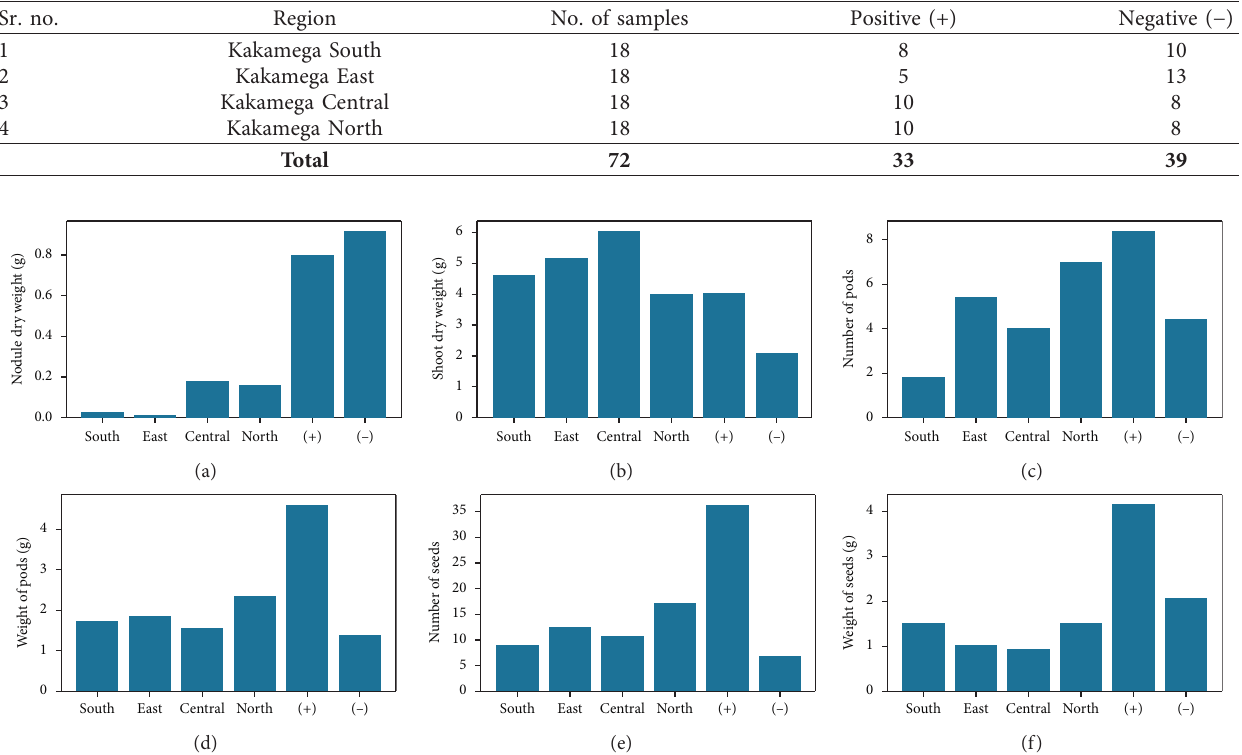
Table 3: Isolation of rhizobia from the root nodule of soybean.